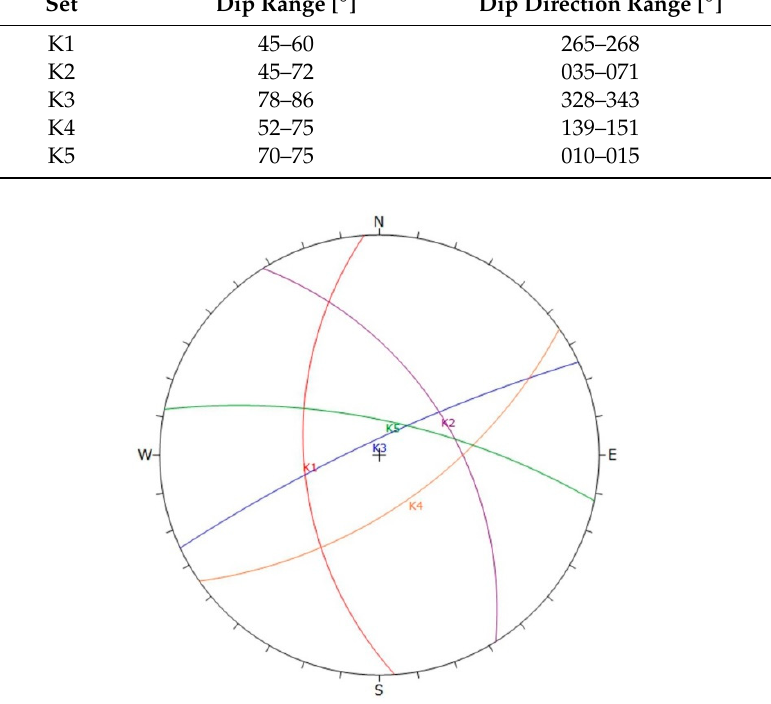
Figure 11. Main discontinuity sets obtained from in situ survey (orientation in Table 2).